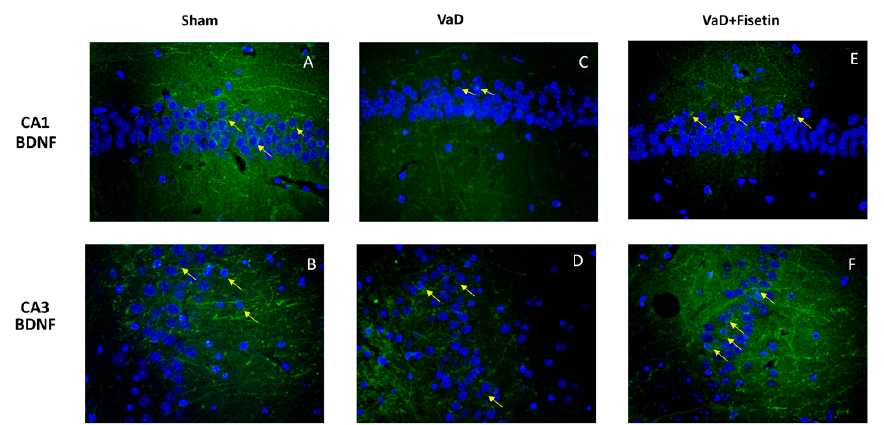
Figure 5. Fisetin administration on BDNF factor expression after VaD induction. Immunofluorescence for BDNF (green) in CA1 and CA3 regions in sham animals ( A , B ), in VaD animals ( C , D ), and treated with Fisetin ( E , F ). Figures are from at least three divided experiments.